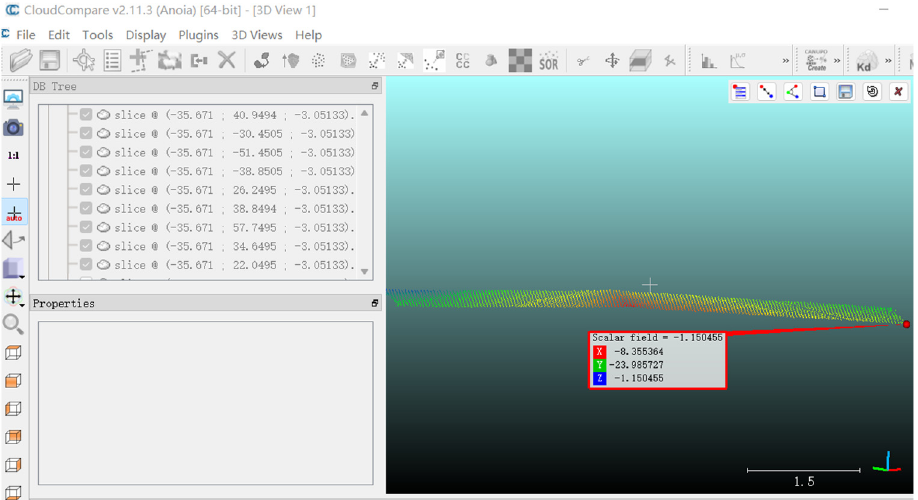
Figure 15. Manual measurement of the geometric information. Table 3. Error Between Extraction Methods and Manual Measurement.